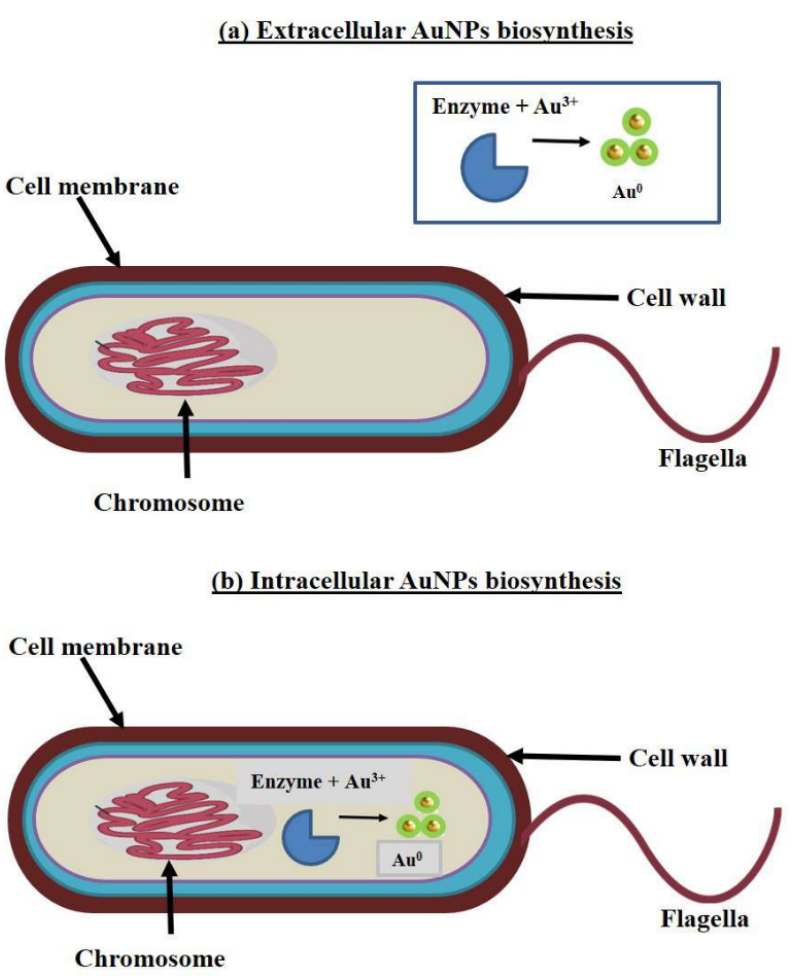
Figure 5. Schematic mechanism of ( a ) extracellular and ( b ) intracellular AuNPs